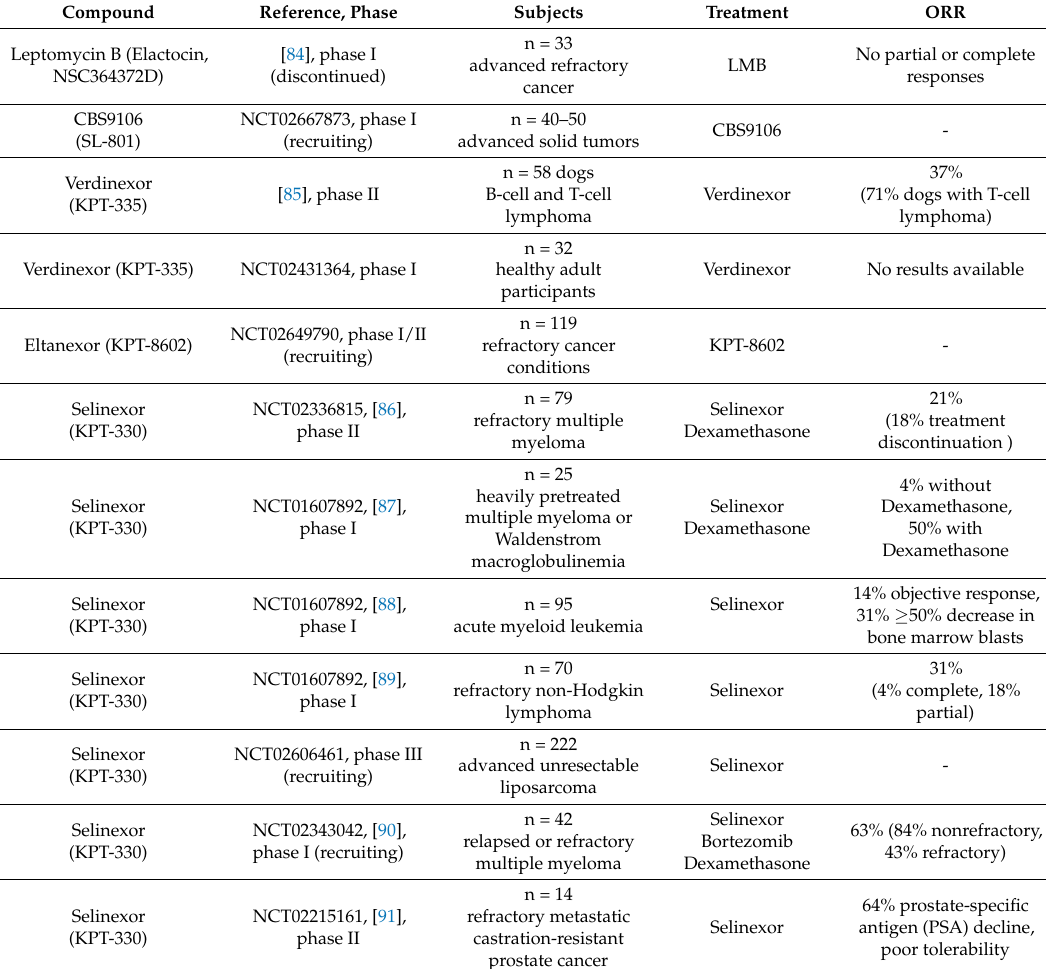
Table 2. Selected clinical trials with protein nuclear export